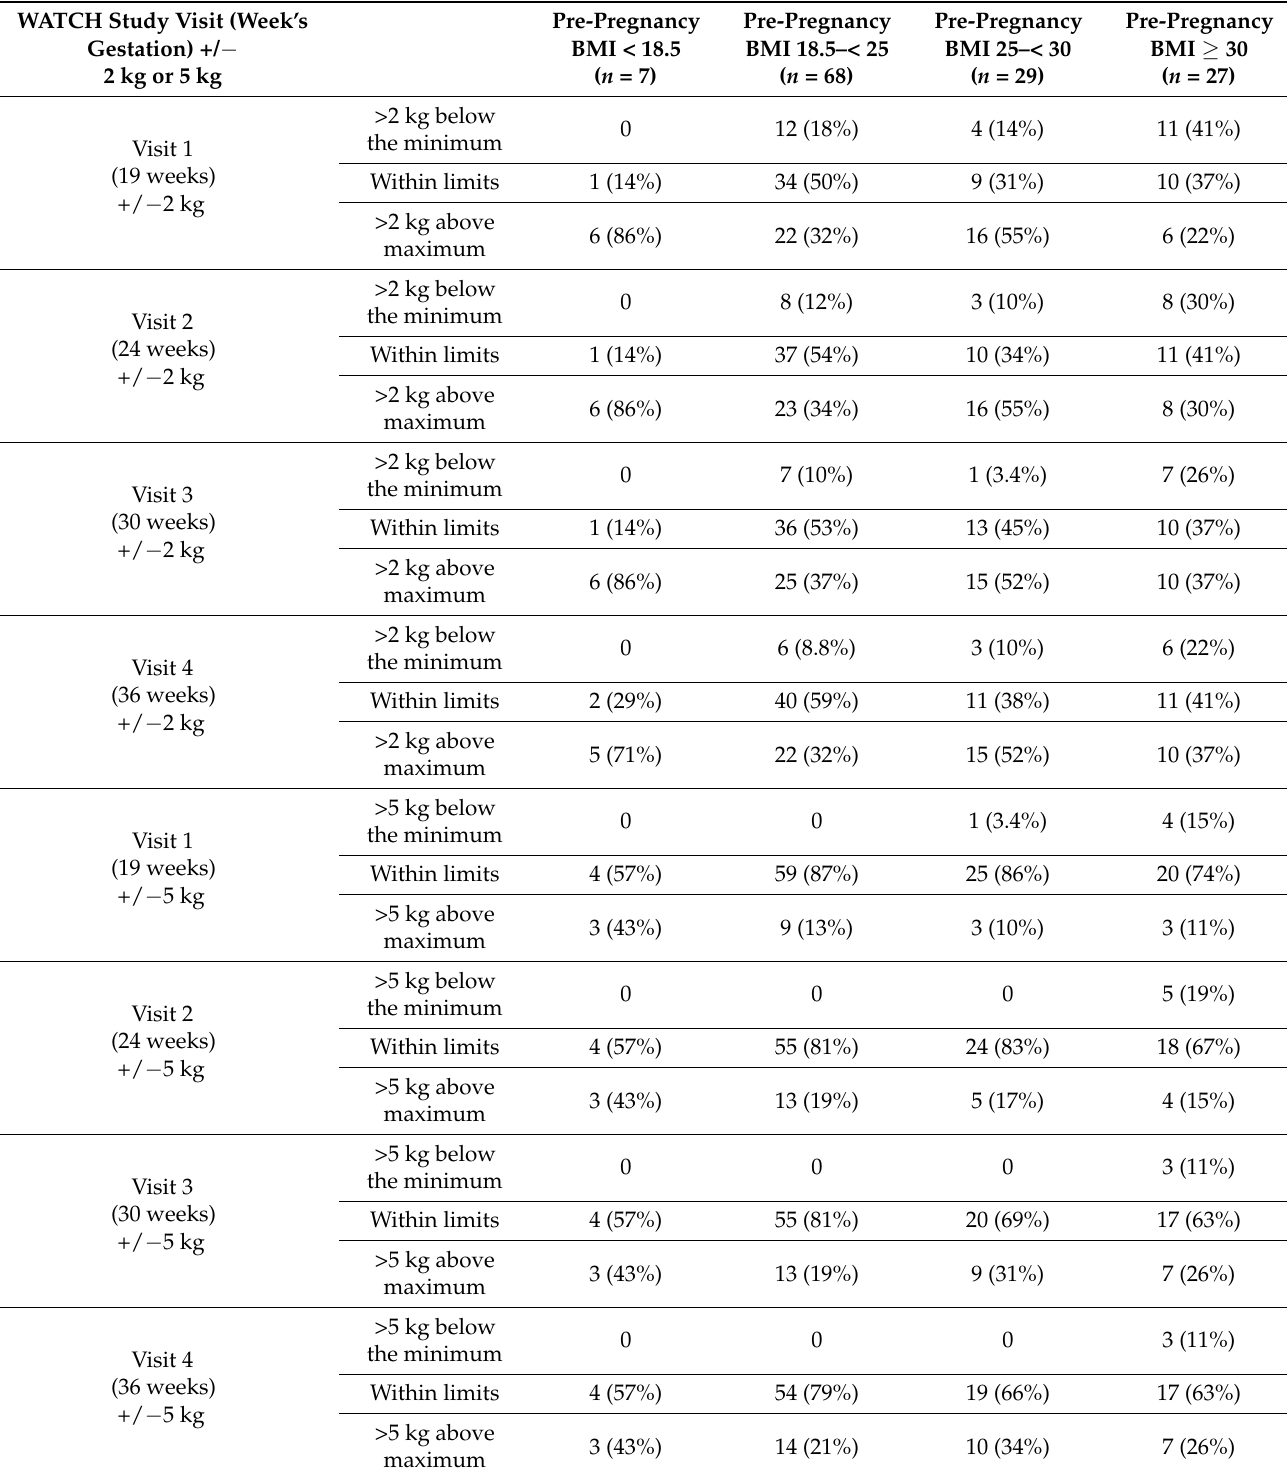
Table 1. Distribution of gestational weight gain by WATCH study